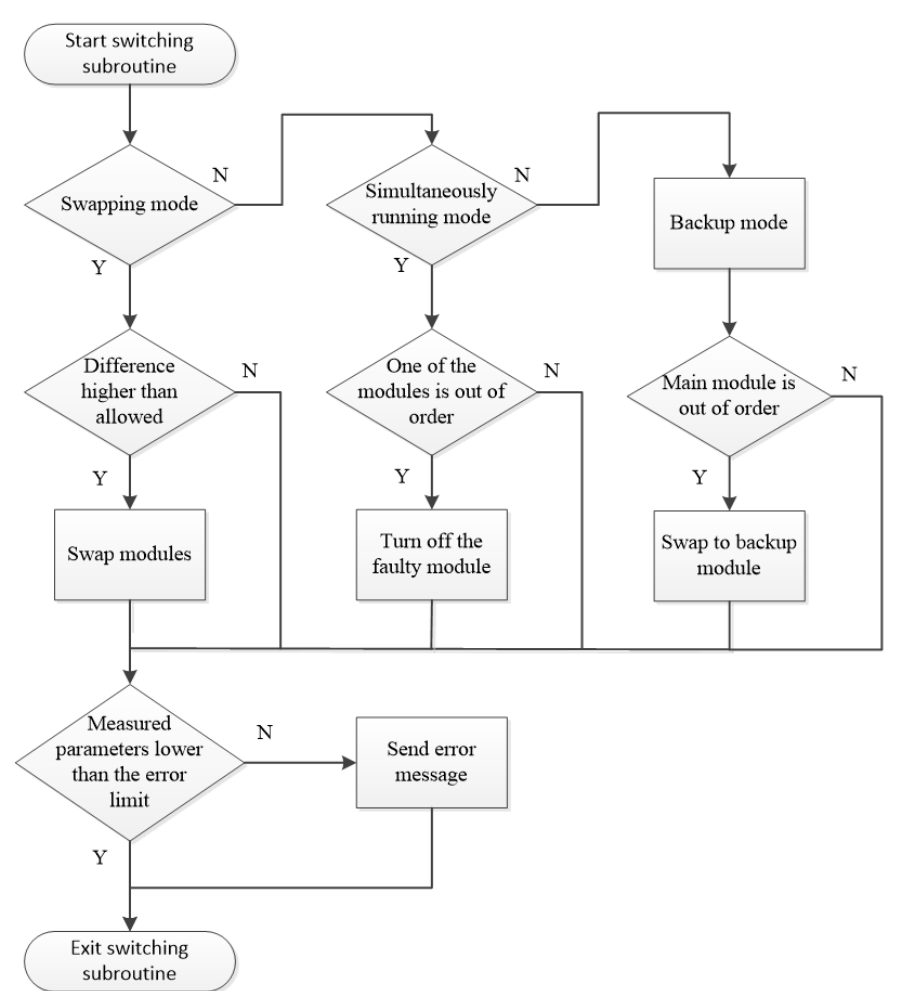
Figure 13. Mode selector